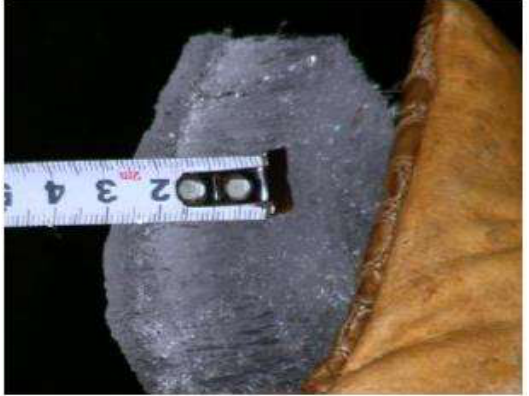
Figure 5. Ice made in the basin [15].